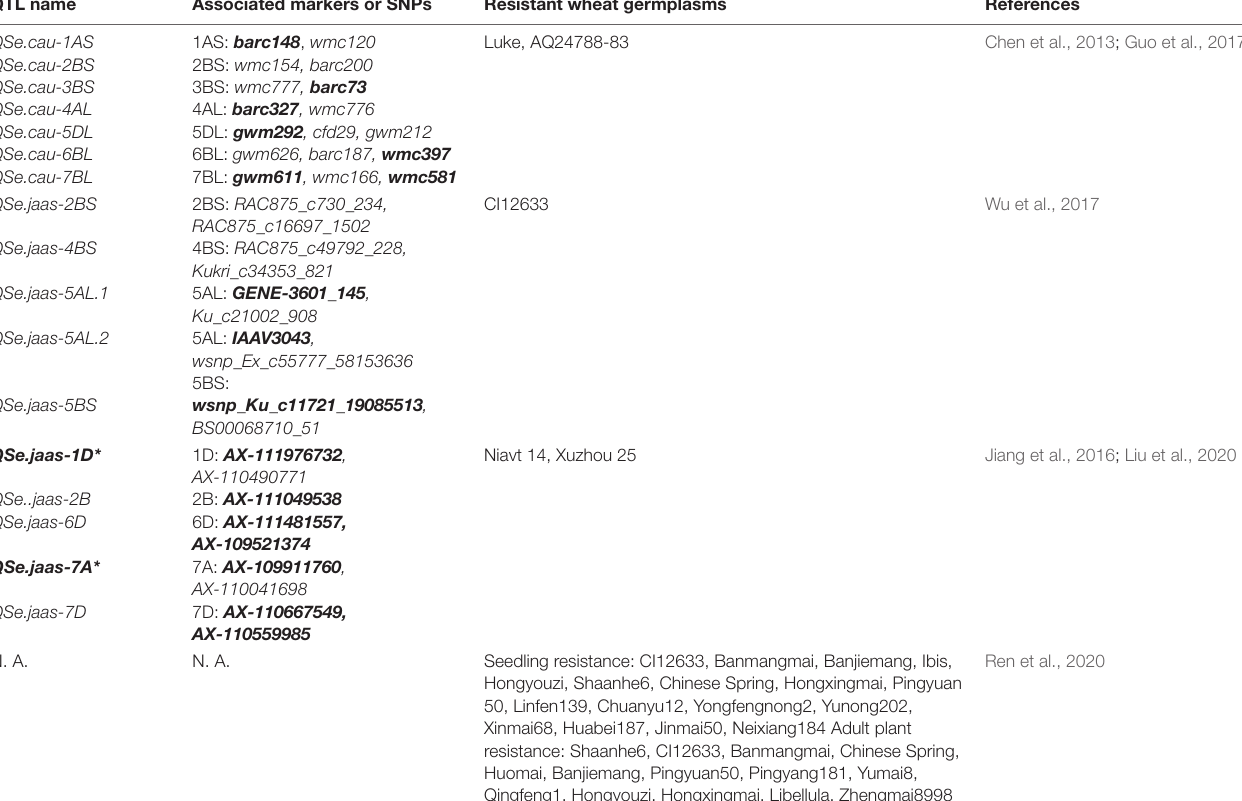
TABLE 3 | Genetic determinants of wheat resistance to sharp